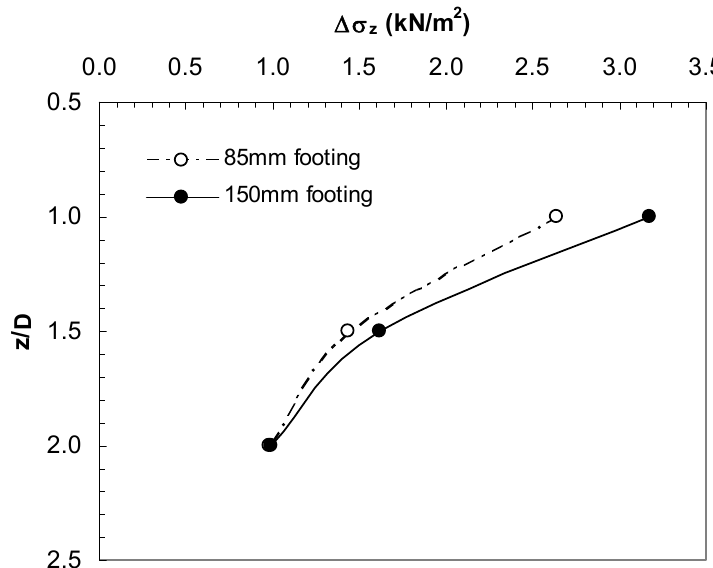
Figure 10. Measured vertical stress values for circular footings.